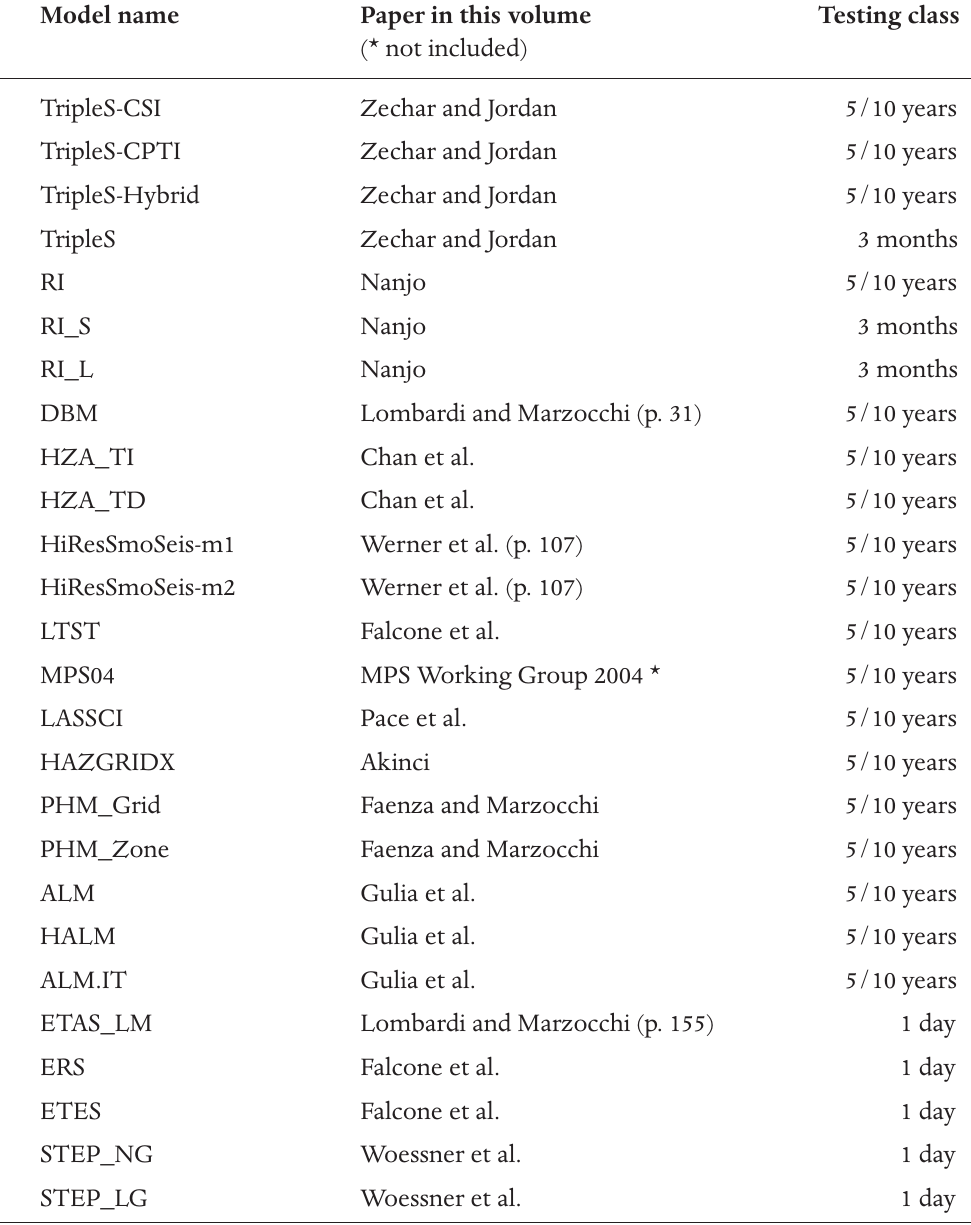
Table 1. The models submitted for the CSEP experiment in